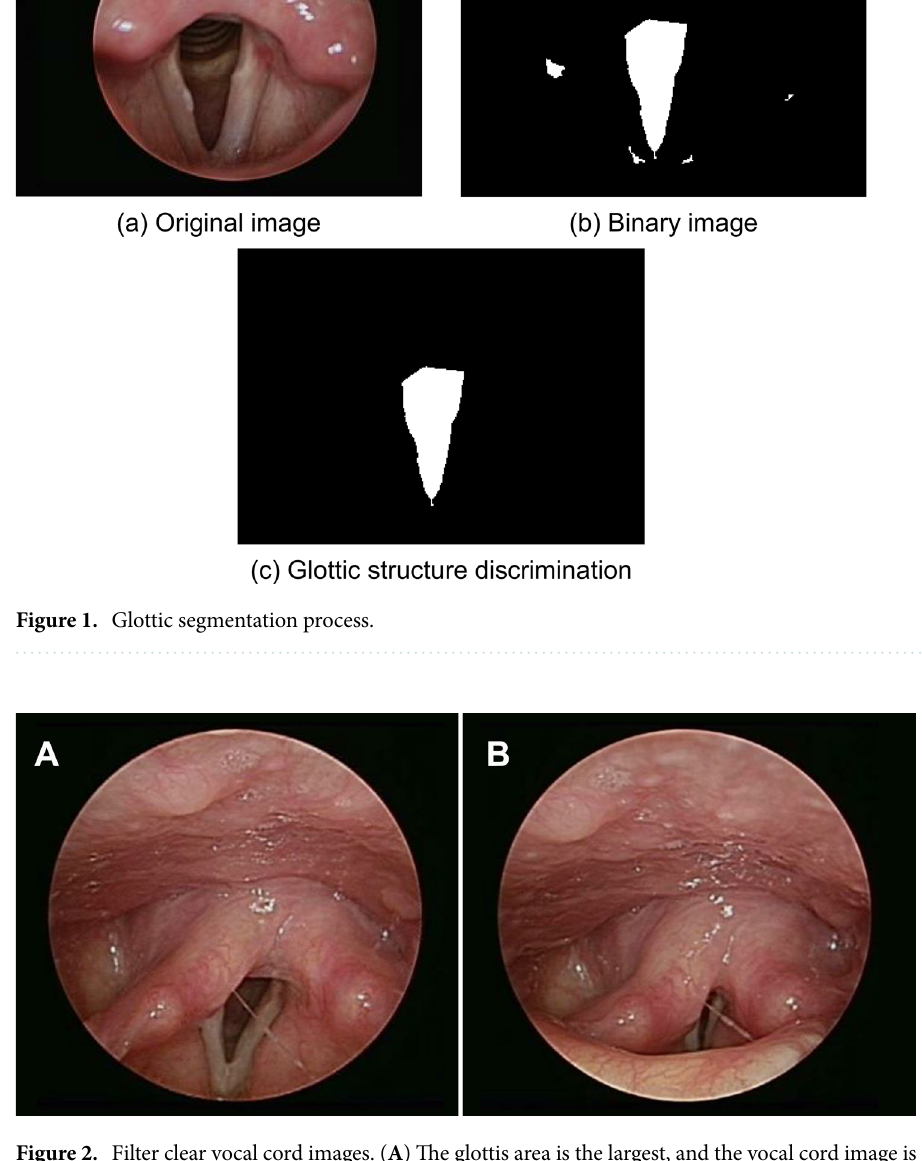
Figure 2. Filter clear vocal cord images. ( A ) The glottis area is the largest, and the vocal cord image is clear. ( B ) The glottal area is too small, and the vocal cord image is